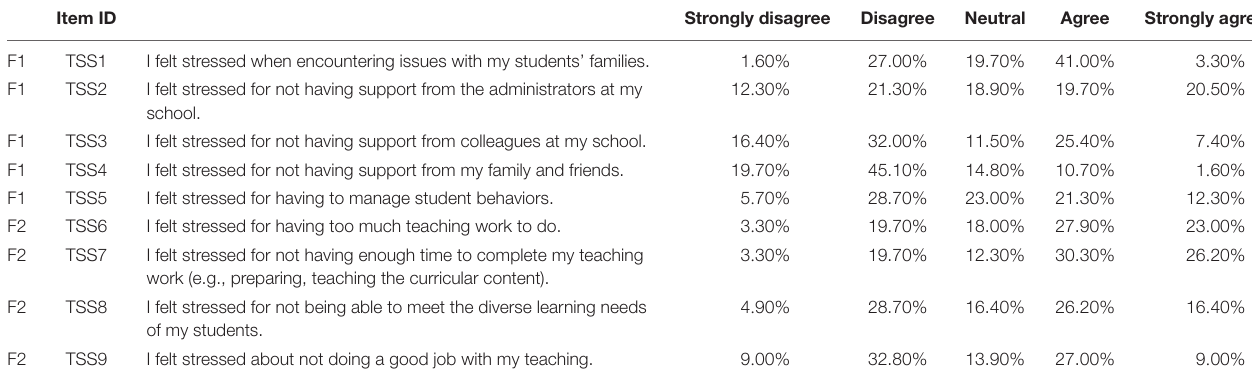
TABLE 1 | The Teacher Stress Scale’s (TSS) original 2-factor (F) design and response category